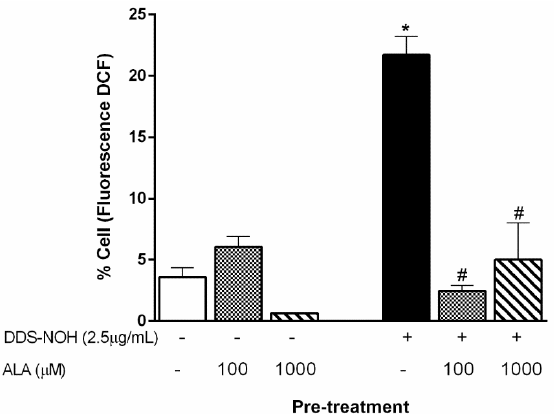
Figure 2. Effect of pretreatment with ALA on reactive oxygen species (ROS) generation induced by DDS-NOH. Erythrocytes were pretreated with ALA (100 and 1000 µ M) for 1 h at 37 ◦ C and incubated DDS ‐ NOH. Erythrocytes were pretreated with ALA (100 and 1000 μ M) for 1 h at 37 °C and for 30 min with DDS-NOH (2.5 µ g/mL). ROS production was measured as dichlorofluorescein (DCF) incubated for 30 min with DDS ‐ NOH (2.5 μ g/mL). ROS production was measured as fluorescence. Values are means ± S.E.M. * p < 0.05 compared to methanol. # p < 0.05 compared to the dichlorofluorescein (DCF) fluorescence. Values are means ± S.E.M. * p < 0.05 compared to methanol. DDS-NOH # p < 0.05 compared to the DDS ‐ NOH group.